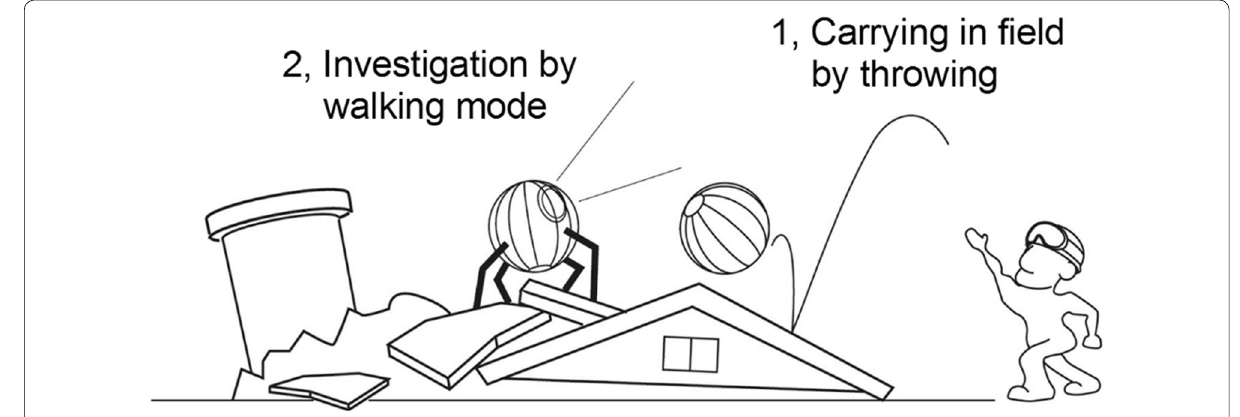
Fig. 1 Application concept of our robot